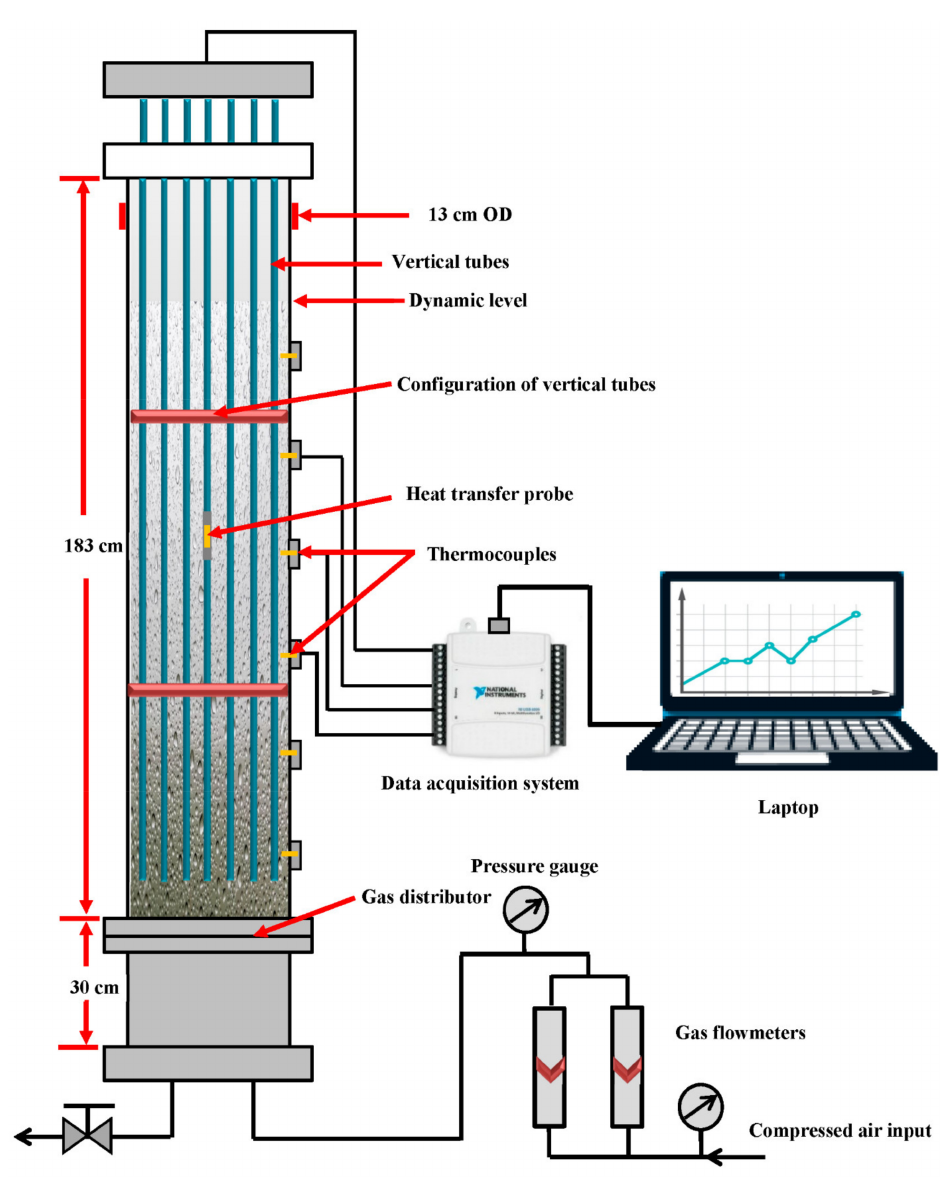
Figure 1. Schematic diagram of experimental bubble column equipped with a bundle of